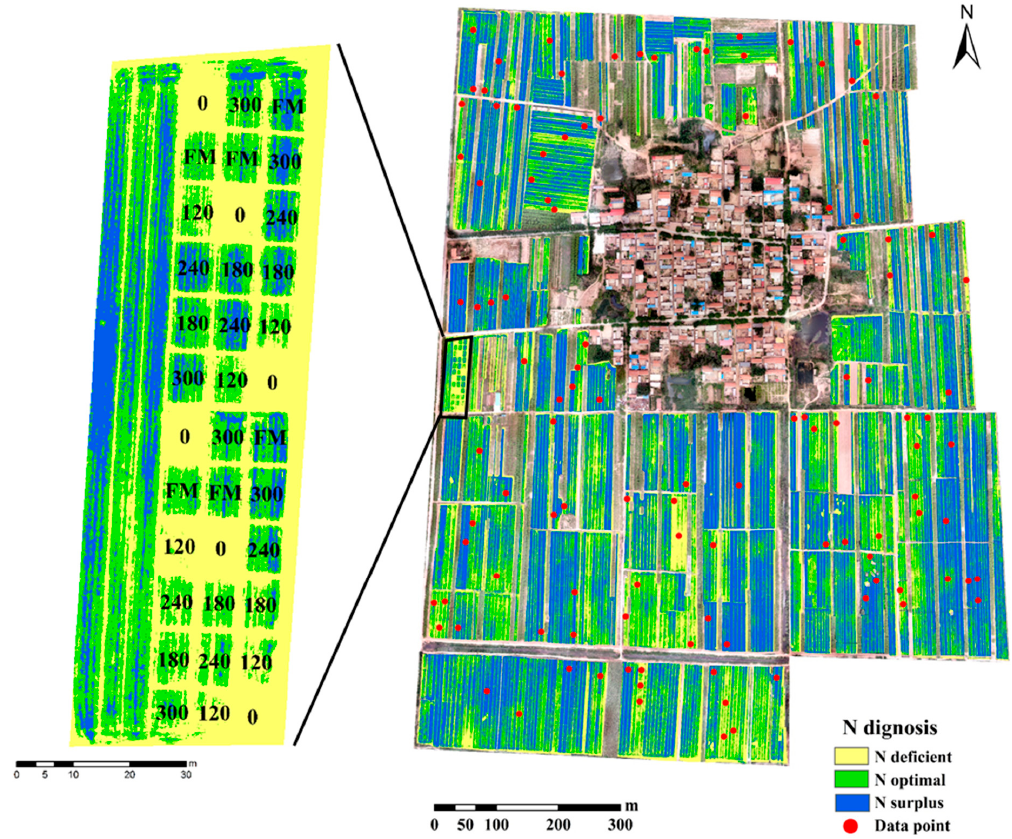
Figure 6. The N diagnosis maps created using the NNI-NSI approach with NSI_REWDRVI for the village’s fields at the pixel level in 2017, Nanxia village, Laoling county, Shandong Province in the North China Plain. Red dots ( n = 114) depict the biomass sampling locations in farmer’s fields. The experimental field trial with the 36 sampling plots is shown, where FM indicate farm management, whereas 0, 120, 180, 240, and 300 indicate 0, 120, 180, 240, and 300 kg N ha − 1 .